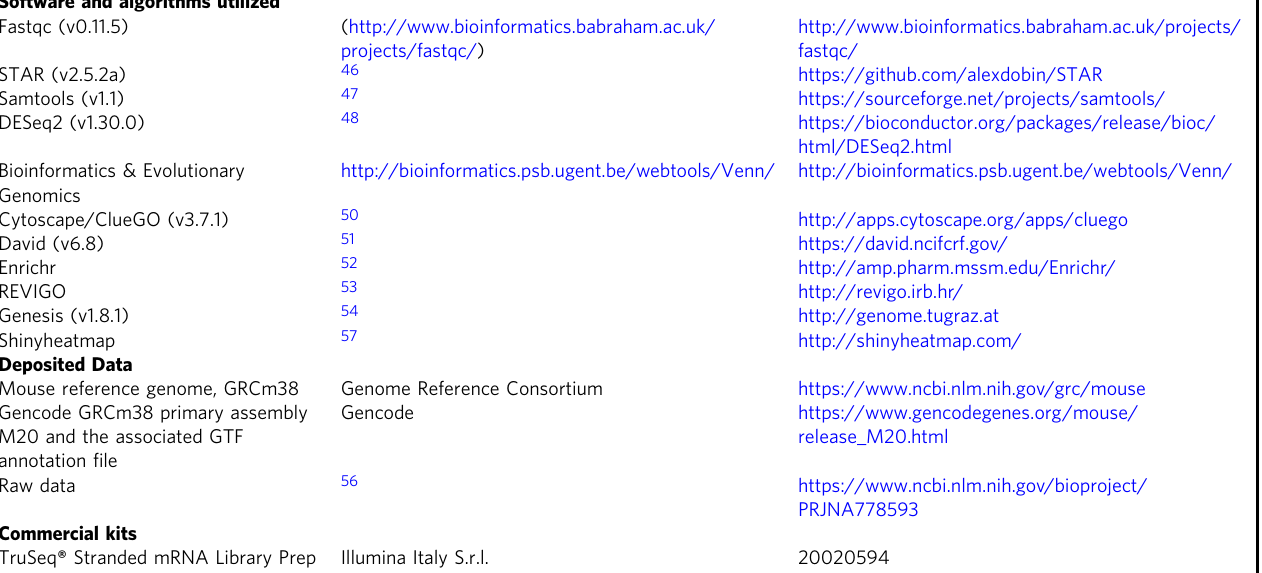
RNA-sequencing sample and library processing . RNA from liver of control (ER α f/f ) and LERKO mice was isolated with TRIzol (Invitrogen) and puri fi ed using